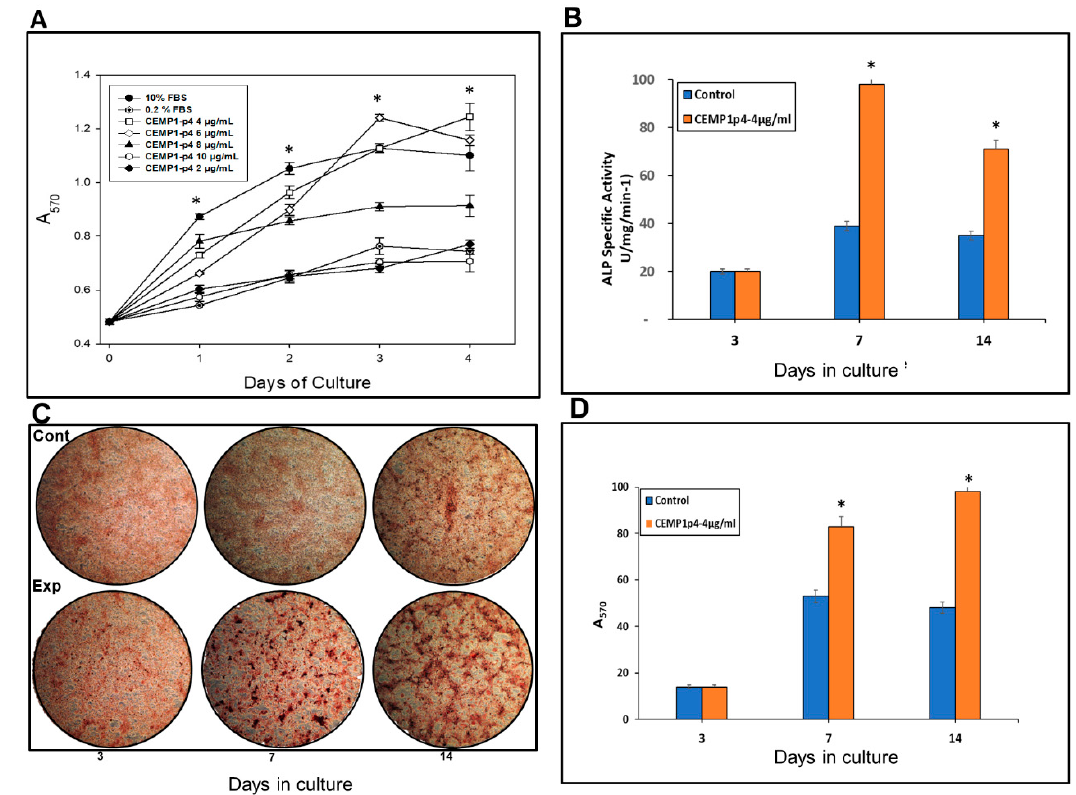
Figure 3. ( A ) Human oral mucosal stem cells (HOMSCs) were treated from 0 up to 96 h with several CEMP1-p4 concentrations where 4 µ g / mL was shown to be optimal for cell proliferation. ( B ) CEMP1-p4 at 4 mg / mL increases alkaline phosphatase (ALP)-specific activity on HOMSCs at 7 and 14 days. ( C ) Representative images showing ARS after osteogenic induction on HOMSCs by CEMP1-p4 at 4 mg / mL during 3, 7, and 14 d of culture. ( D ) Mineral formation was quantified by cetylpyridinium chloride (CPC), showing that CEMP1-p4 is a potent inductor of calcium salts. * p < 0.05.